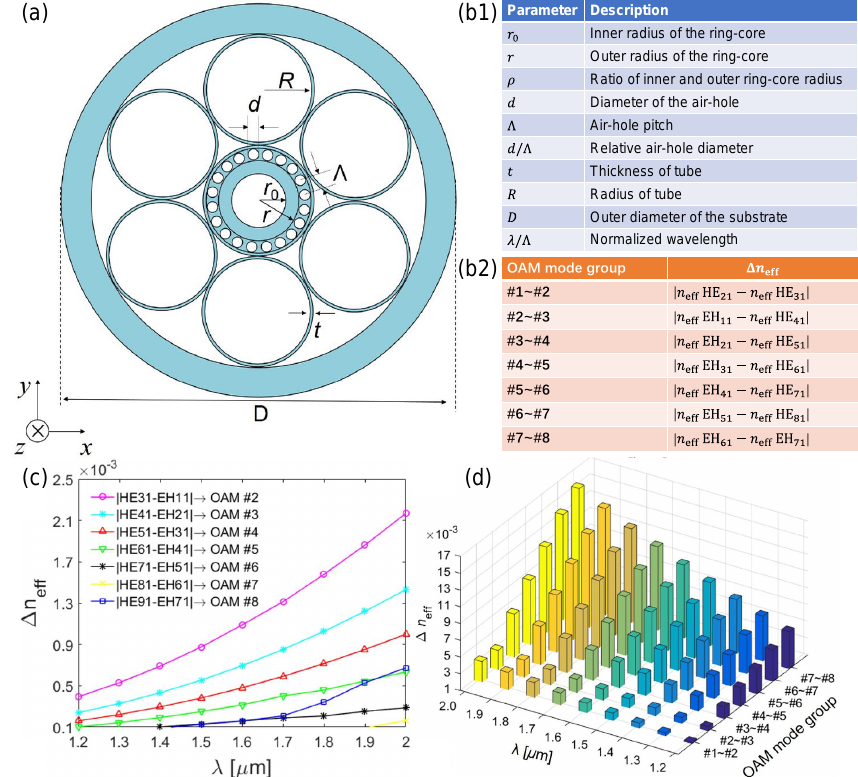
Figure 11. ( a ) The cross section of the proposed NC-RCF. ( b1 ) The description of each structure parameter. ( b2 ) The modes used to calculate the minimum ∆ n eff in ( d ). ( c ) The ∆ n eff between the adjacent vector eigenmodes in each OAM mode group when r = 7 µ m, ρ = 0.65, t = 1.2 µ m, and d / Λ = 0.8. ( d ) The minimum ∆ n eff between OAM mode groups. Adapted with permission